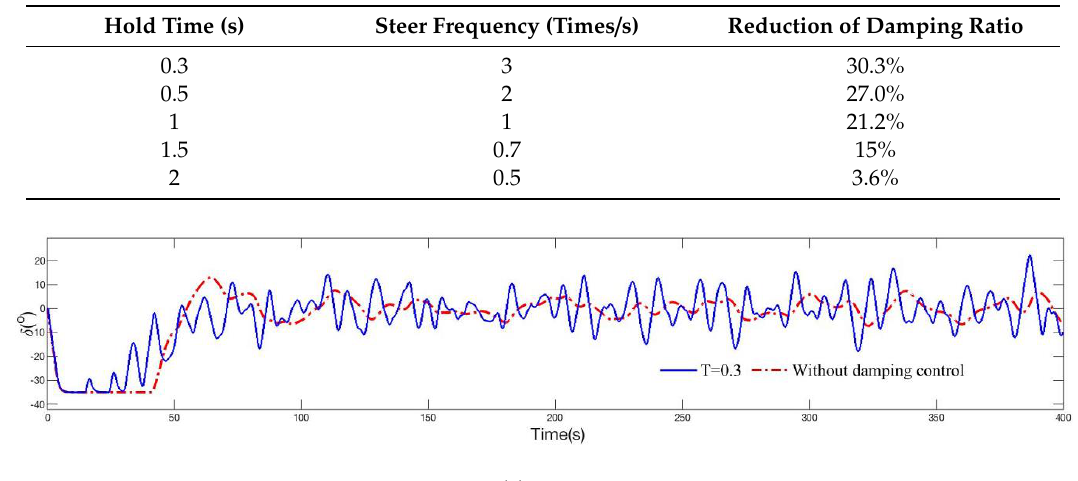
Figure 11. Rudder angle under different control.